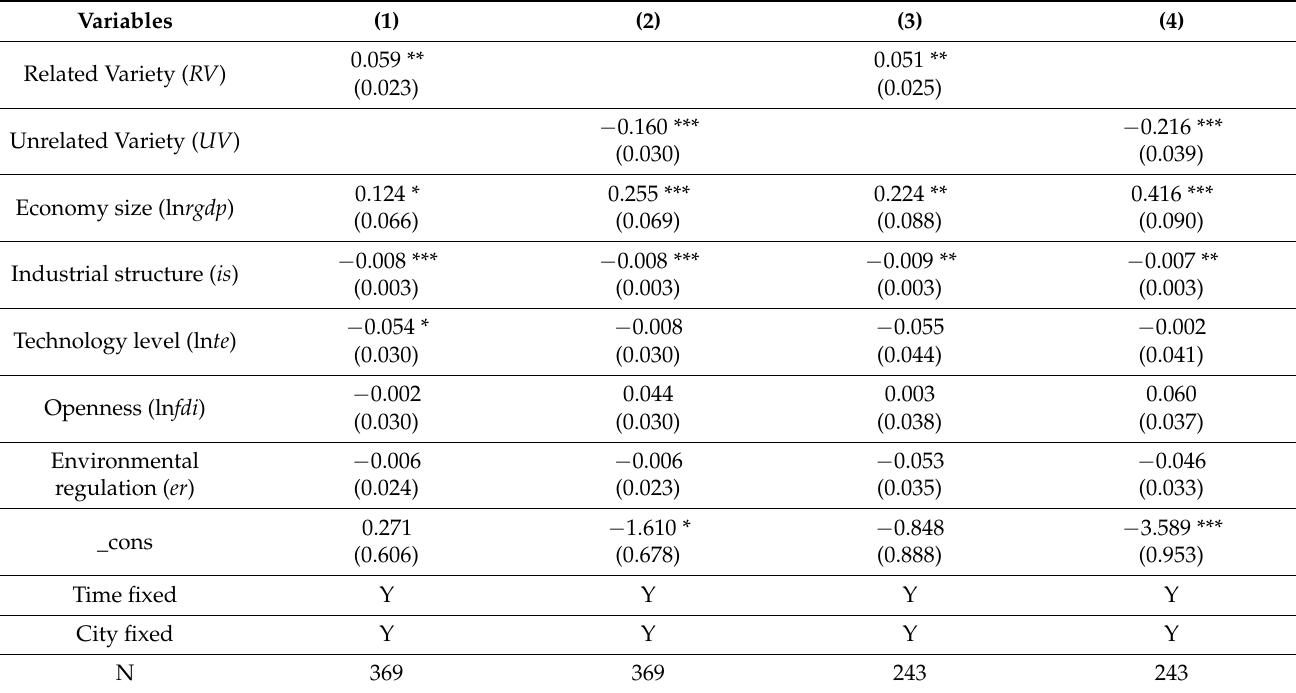
Table 3. Empirical results of knowledge diversity in the Yangtze River Delta region on the efficiency of urban green innovation from 2010 to